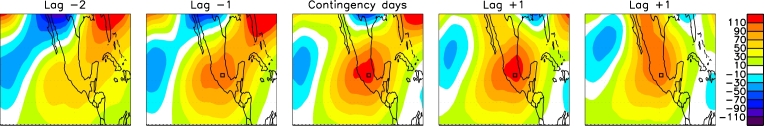
Composites of geopotential height anomalies at 500 hPa (m) for the extreme ozone events (MAM, 2005–2016, middle panel), 2 days before, and 2 days after these events.